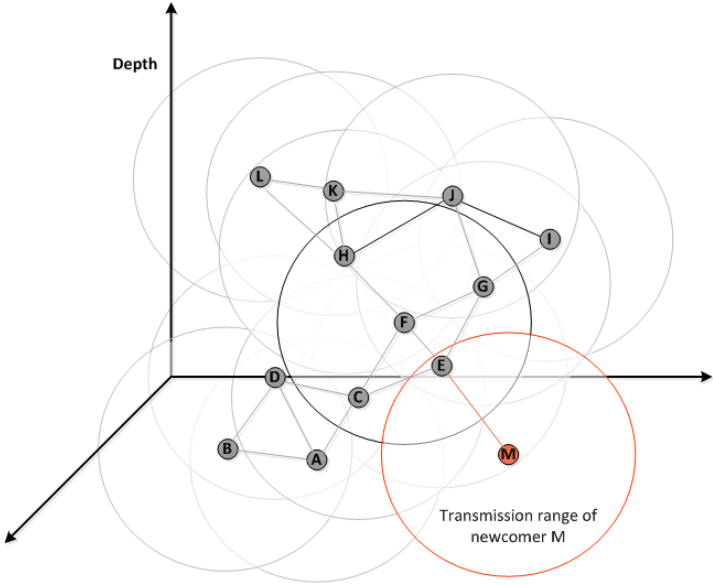
Figure 7. An example of how a newcomer, node M , joins the underwater